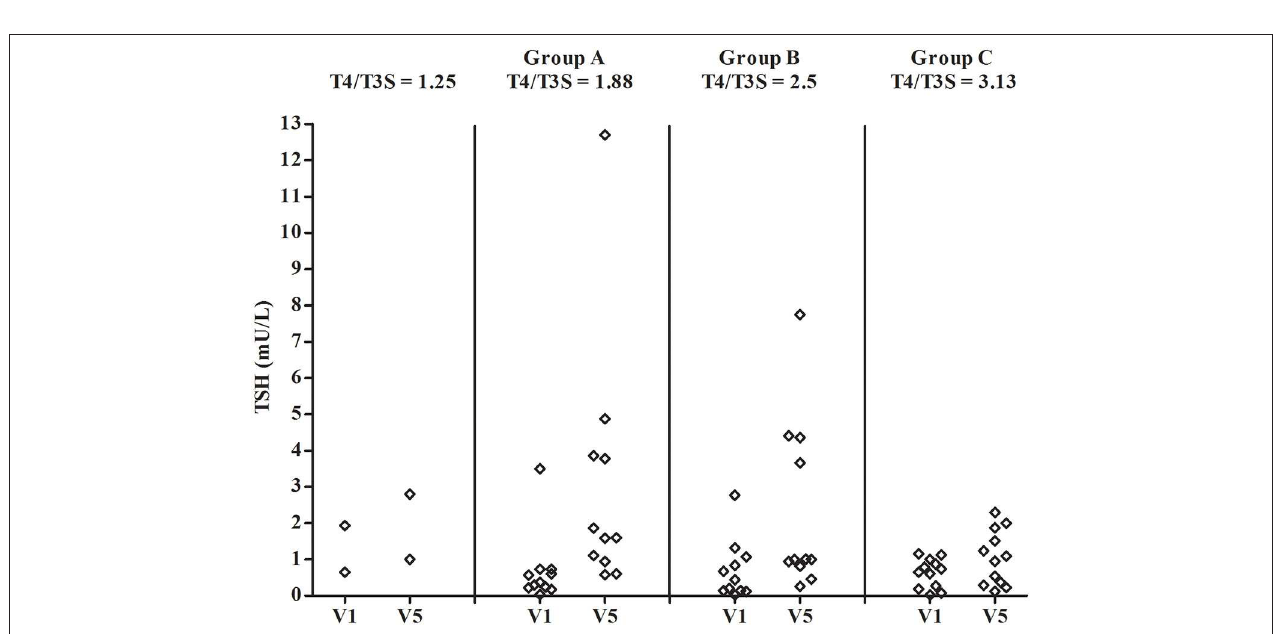
FIGURE 4 | Individual concentrations of serum TSH in patients on L-T4 treatment (V1) and on L-T4 T4/T3S ratio of their treatment regimen: group A dose to 60 and 80 µ g, respectively, are indicated as receiving a T4/T3S ratio